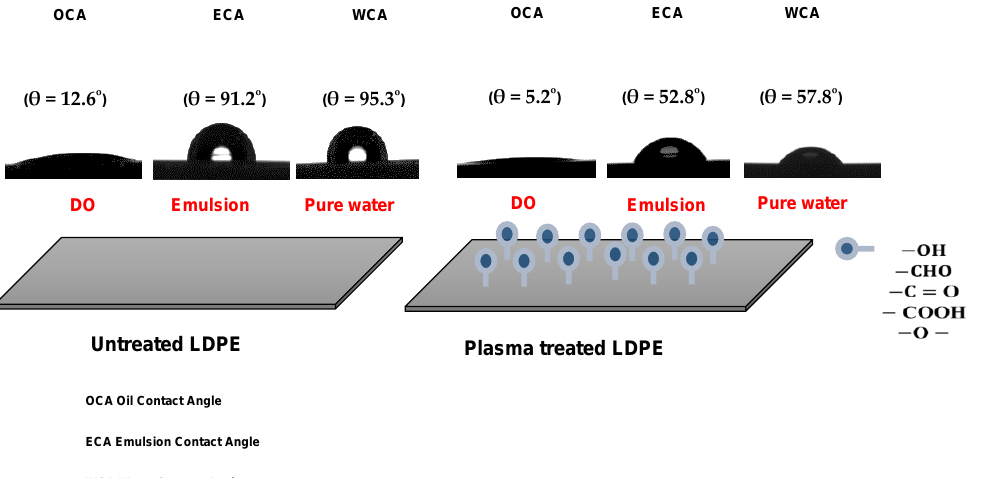
Figure 2. Illustration of the surface wettability of LDPE films.